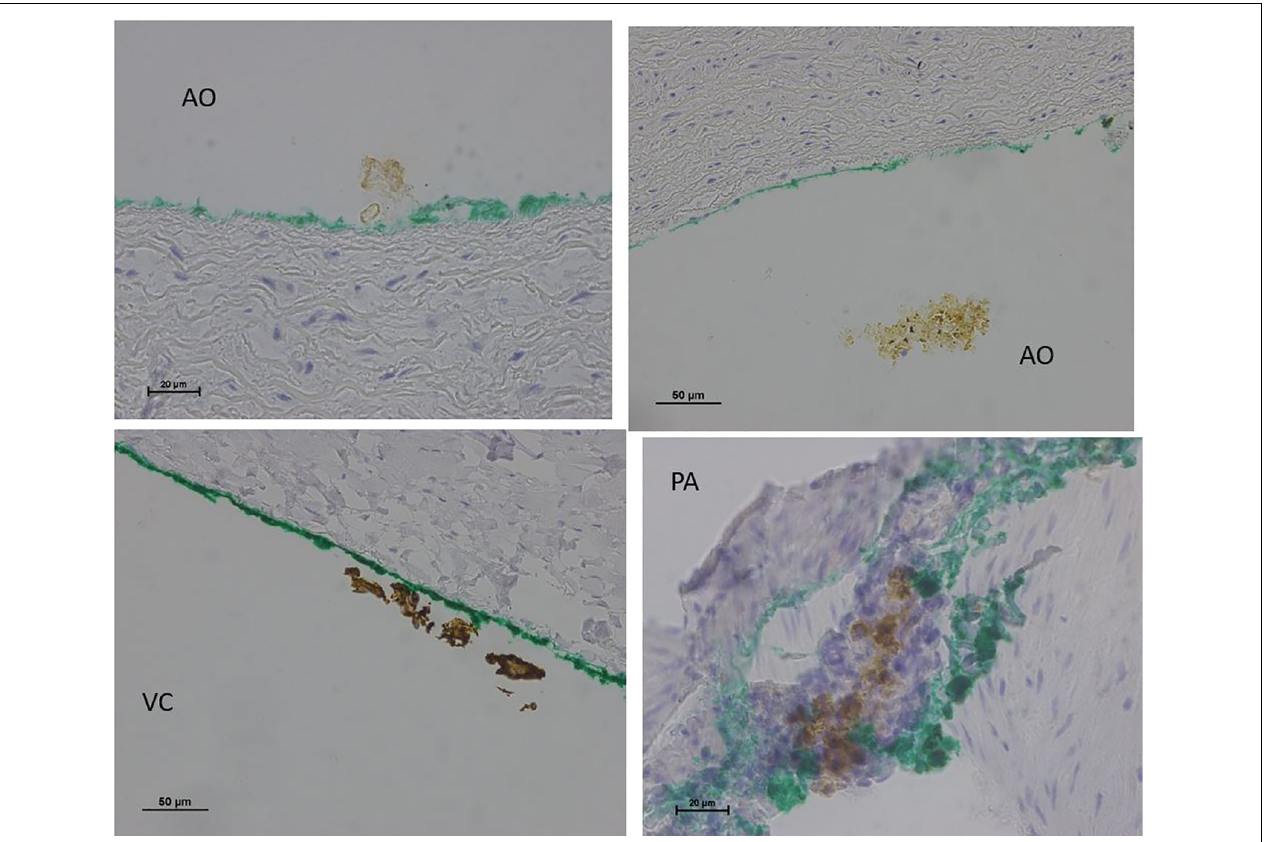
FIGURE 5 | Light microscopy view of the luminal aspect of the blood vessels: aorta-AO, superior vena cava-VC, and pulmonary artery-PA at the AHS. Green line denotes the luminal aspect. There is debris or detached cluster of the endothelial cells (brown